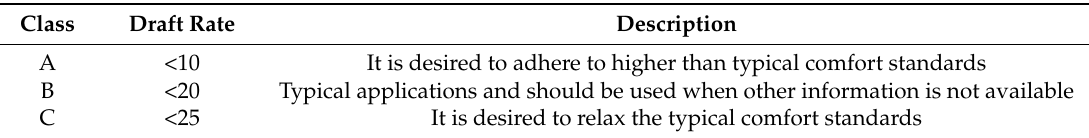
Table 1. Class level of draft